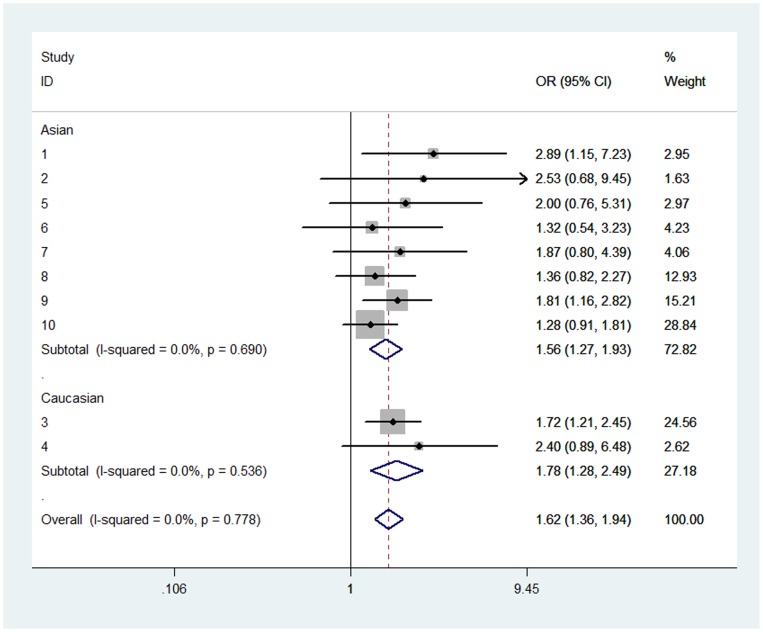
Forest plot of dominant model (GA/GG vs. AA) for overall comparison in fixed-effects model.(OR = 1.624, 95%CI: 1.361, 1.938; Pheterogeneity = 0.778).